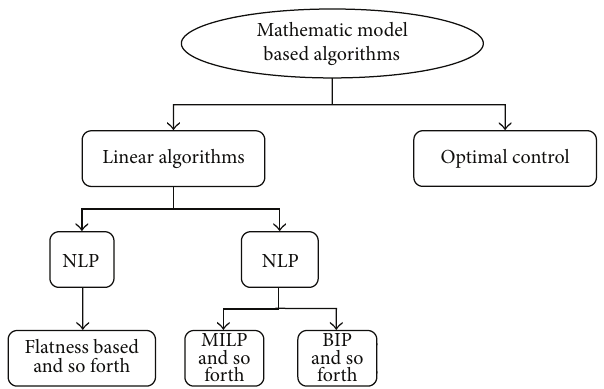
Figure 5: Elements of mathematic model based algorithms.